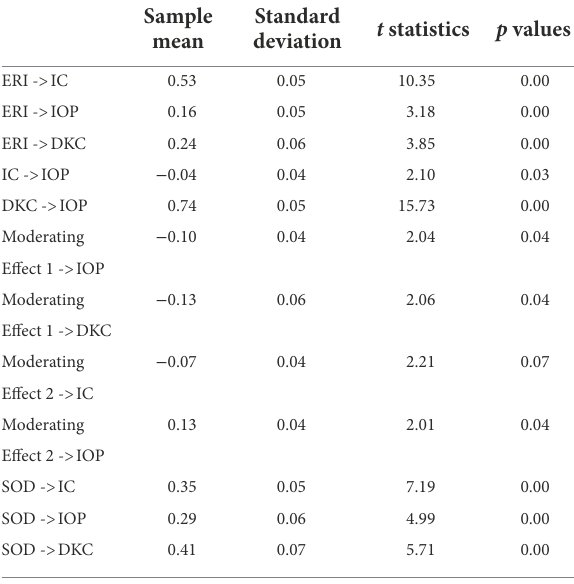
TABLE 5 Total effects of construct items.